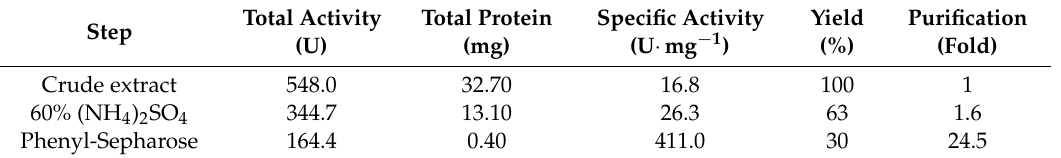
Table 4. Purification of